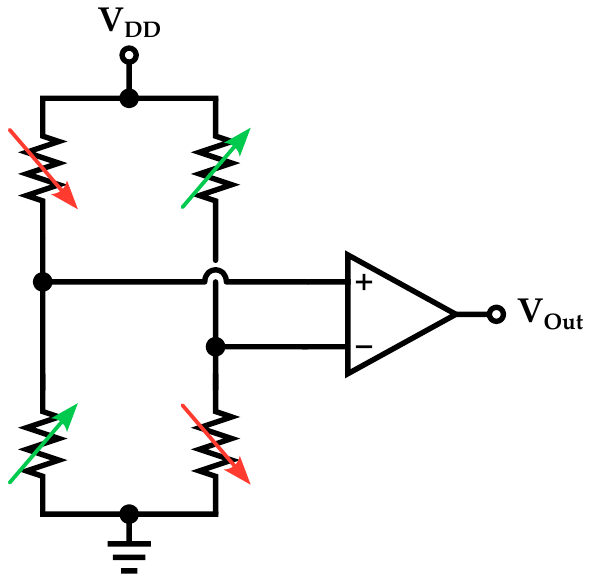
Figure 15. Schematic representation of the pre-amplifier circuit for a piezoresistive MEMS